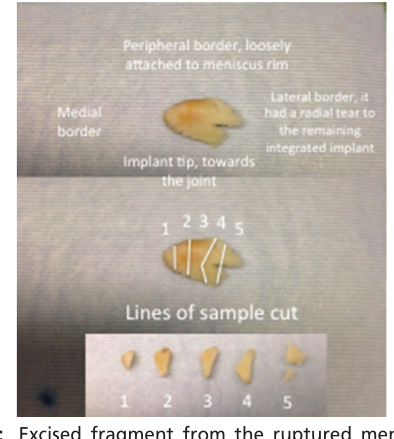
Hematoxilin-Eosin. Microscopic reconstruction. Please Fig. 3a: note the triangular shape, the presence of horizontal dark red lines and the filling with cells and matrix throughout the implant. The most important finding were the blood vessels in the periphery of the implant. The collagen fibers are present throughout the whole implant, but are less dense in the most peripheral area, attached to the meniscal rim.